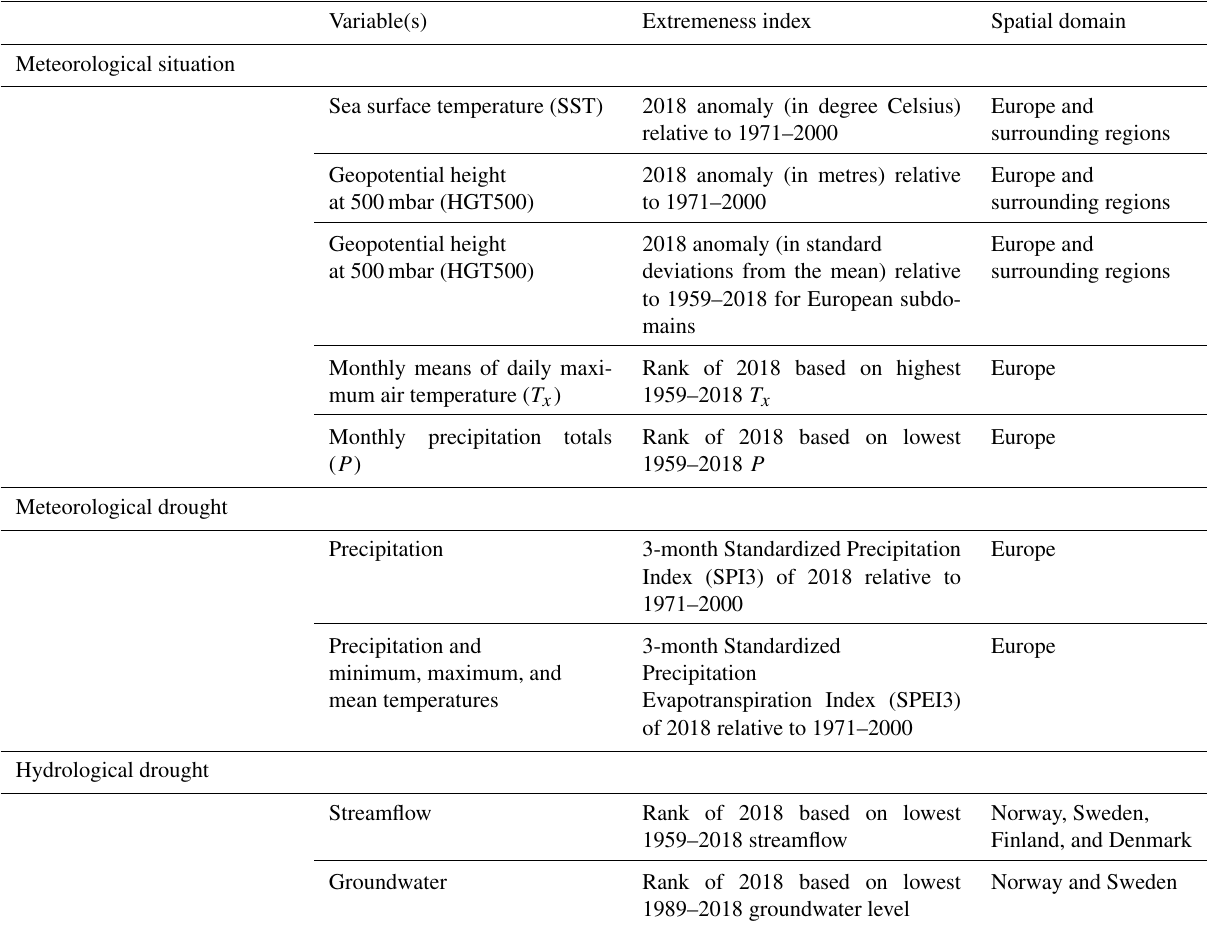
Table 2. Variables, extremeness indices, and spatial domain used to characterise the 2018 meteorological situation, meteorological drought, and hydrological drought. All indices are calculated on a monthly